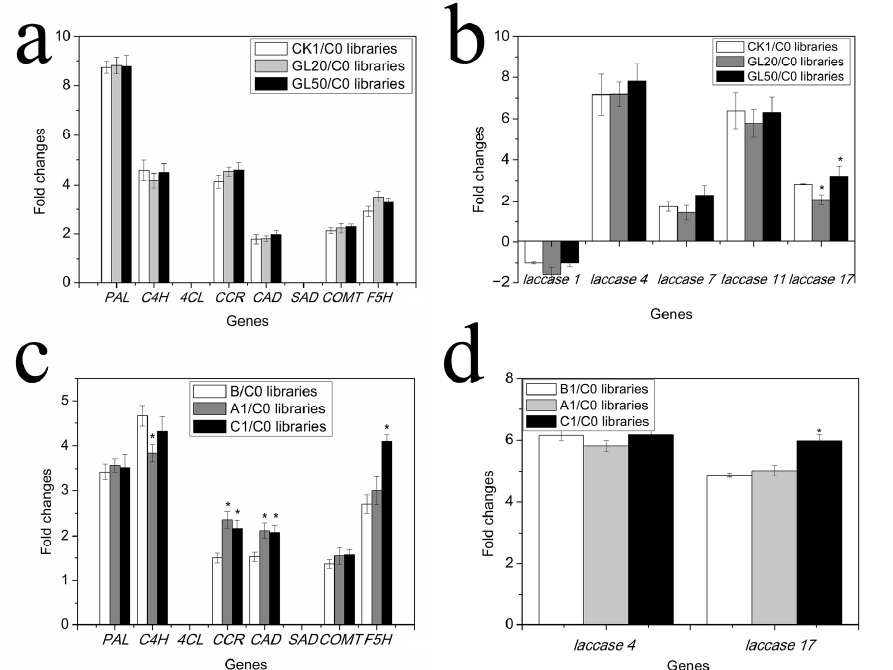
Figure 4. The expression of genes related to lignin synthesis during ARs formation in lotus seedlings. ( a ) The expression of genes related to monomer lignin synthesis in the GL20 and GL50 libraries. ( b ) The expression of genes related to polymer lignin synthesis in the C0, CK1, GL20, and GL50 libraries. ( c ) The expression of genes related to monomer lignin synthesis in the C0, A1, B, and C1 libraries. ( d ) The expression of genes related to polymer lignin synthesis in the C0, A1, B, and C1 libraries. (“*” represents significant difference at 0.05 level, p < 0.05.)